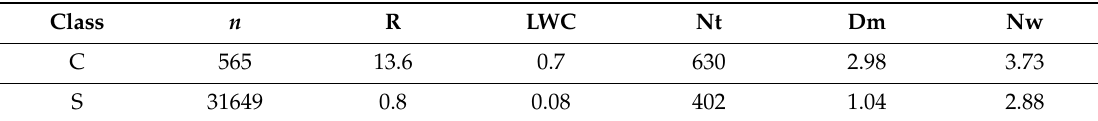
Table 4. Averaged gamma parameters and integral variables calculated for convective (C) and stratiform (S) rains from the RSD dataset between 2017 and 2019 where n is the number of individual samples for each type of rain.